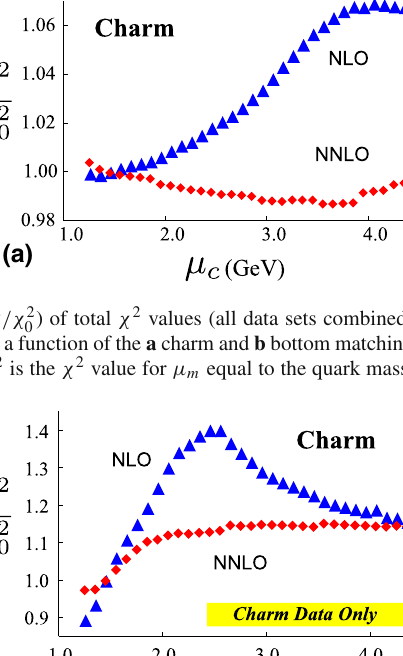
quark mass. The triangles (blue filled triangle) are NLO and the dia- monds (red filled lozenge) are NNLO